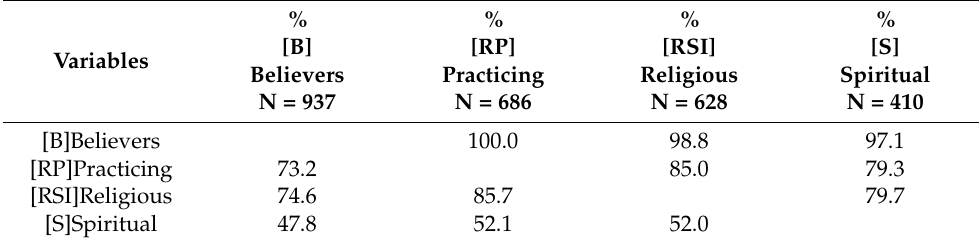
Table 3. Relationships among the dimensions of religiosity.